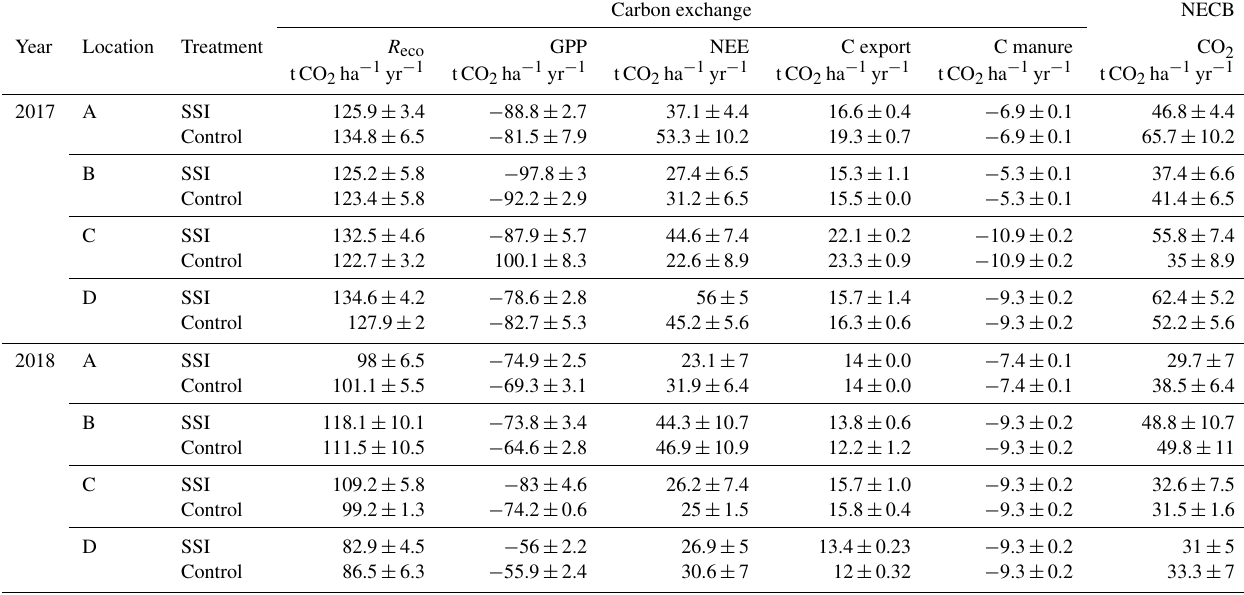
Table 3. Overview of all processes contributing to the carbon balance calculated for both years. Ecosystem respiration ( R eco ), gross primary production (GPP), net ecosystems exchange (NEE, sum of GPP and R eco ), C exports (harvest), C manure (carbon addition from manure application), and net ecosystem carbon balance (NECB, sum of all fluxes) for subsoil irrigation (SSI) and control plots at farm locations A– D. The range of R eco , GPP and NEE represent the combination of model error and extrapolation uncertainties following the law of error propagation.